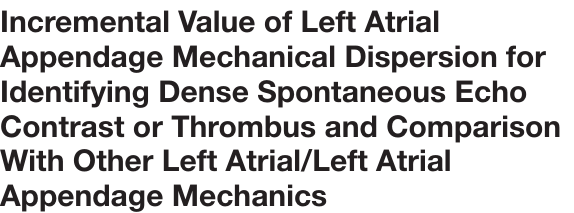
Table 1 . The AUCs for LAA parameters were higher than clinical, LV and LA variables. Importantly, the AUCs for LAA MD (0.82), LAA GLS (0.84), and LA GLS (0.80) were comparable but higher than that of LA MD (0.74, all p < 0.05). The optimal cutoff value for LAA MD to identify LAA dense SEC or thrombus was > 11.2%, with a sensitivity of 80.0% and specificity of 67.16%. We also calculated cutoff values for LAA GLS, LA GLS, and LA